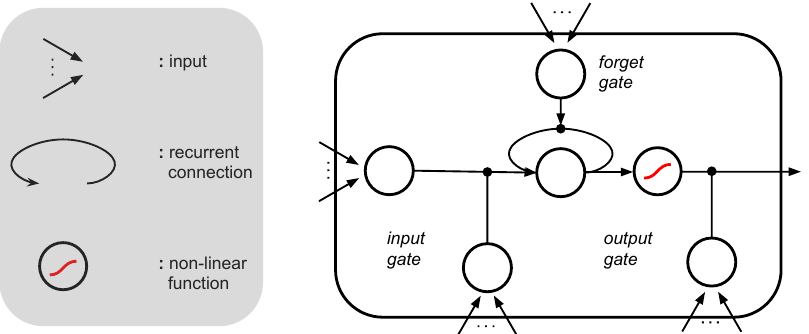
Figure A1. Abstract visualization of LSTM. A set of components on the left describes their roles in a unit on the